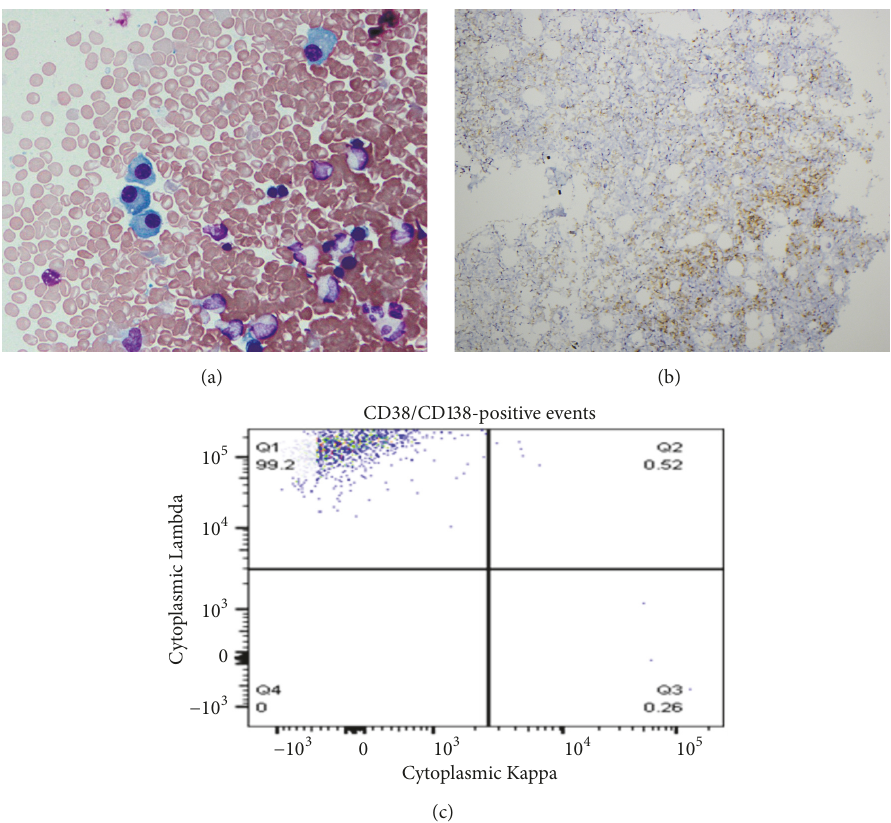
Figure 2: Evidence of a plasma cell neoplasm. (a) Touch prep of the bone marrow biopsy showing numerous plasma cells (arrow, 50x). (b) IHC staining for the plasma cell marker CD138 (10x). (c) Flow cytometric dot plot of CD38/CD138-positive plasma cells from the bone marrow aspirate showing a monotypic lambda-restricted plasma cell